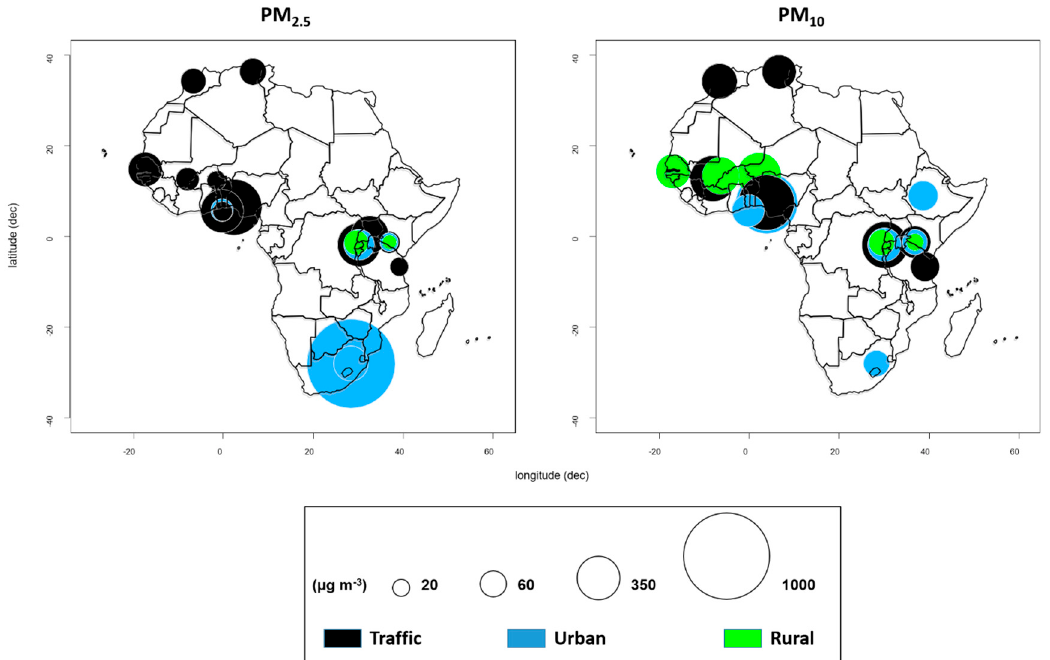
Figure 2. Ambient PM 2.5 (particles less than 2.5 μ m in diameter) (left), and ambient PM 10 (particles less than 10 μ m in diameter) (right), mean concentration as reported in studies from traffic (back color), urban background (blue), and rural site (green) in African countries such as Algeria [45], Benin [46], Burkina Faso [47], Ethiopia [48], Ghana [49,50], Kenya [51], Mali [52], Morocco [53], Niger [54], Nigeria [49], Rwanda [34], Senegal [54,55], South Africa [56,57], Tanzania [58], and Uganda